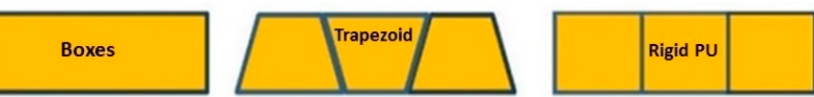
Figure 16. Test setup. Adapted from [59].